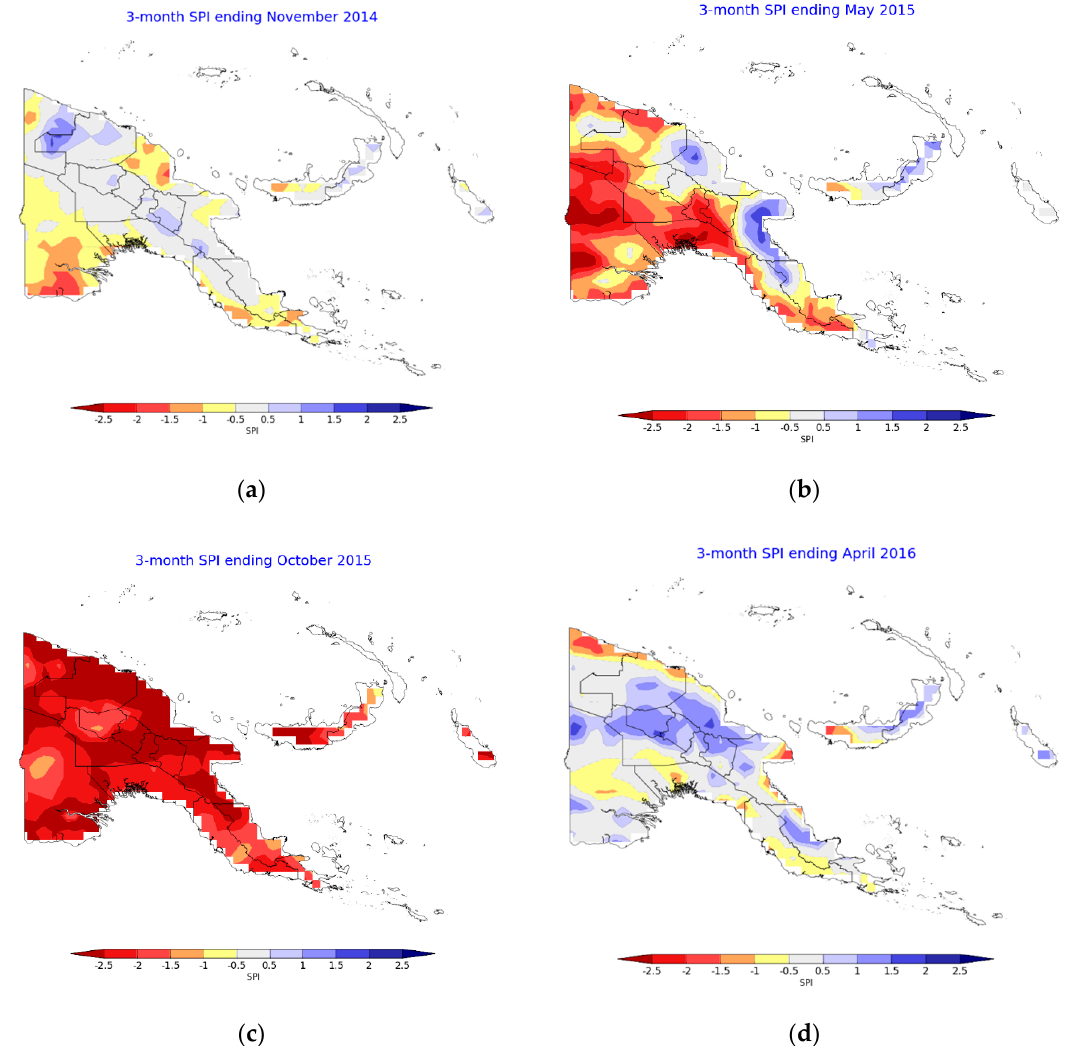
Figure 10. Three-month SPI showing the progression of the 2015–2016 drought event. ( a ) November 2014 showing initial signs of dry conditions towards the southeast of the mainland; ( b ) April 2015 showing more widespread dry conditions developing; ( c ) October 2015 showing widespread severely dry conditions; ( d ) April 2016 showing the easing of dry conditions.